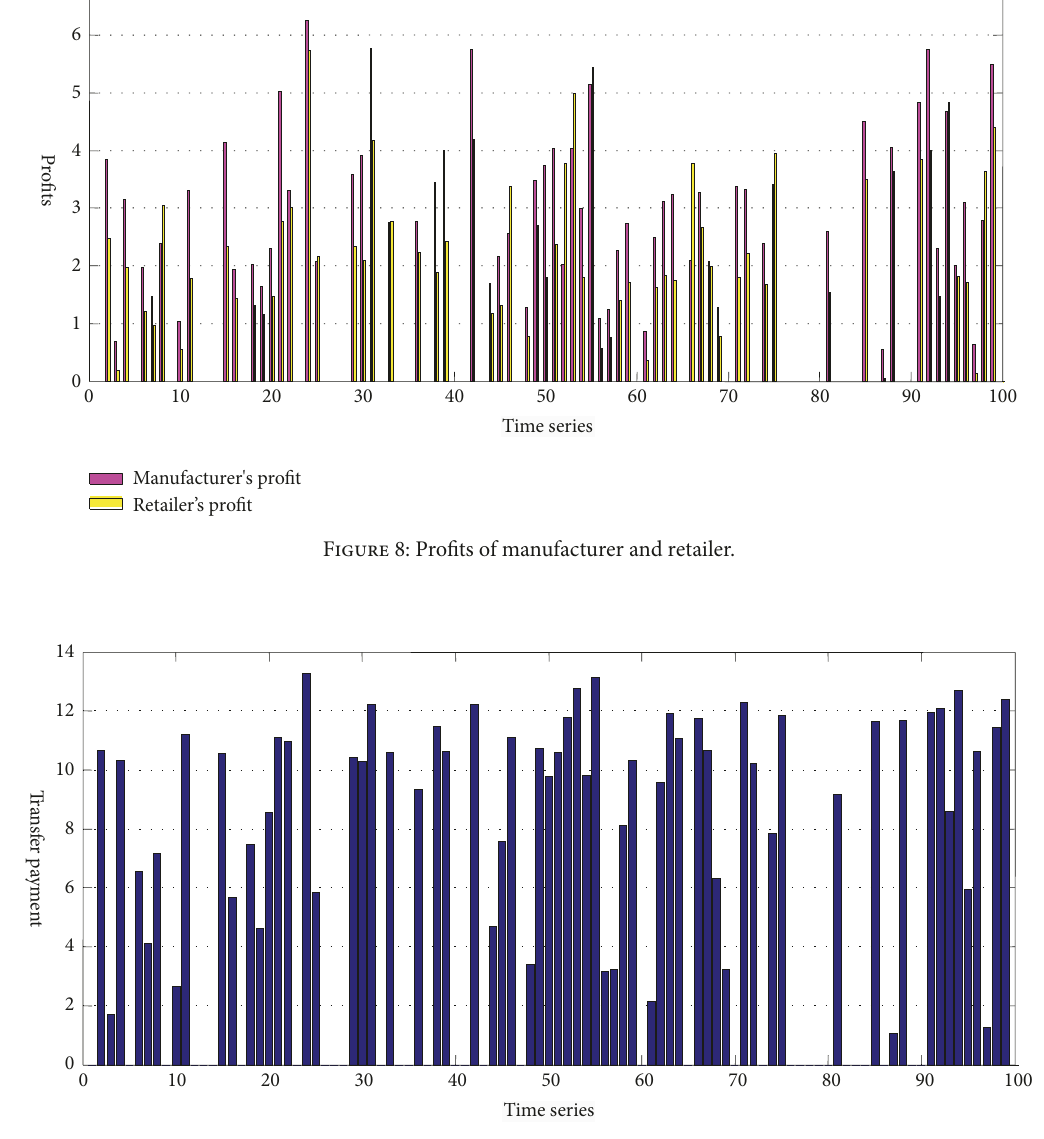
Figure 9: Transfer